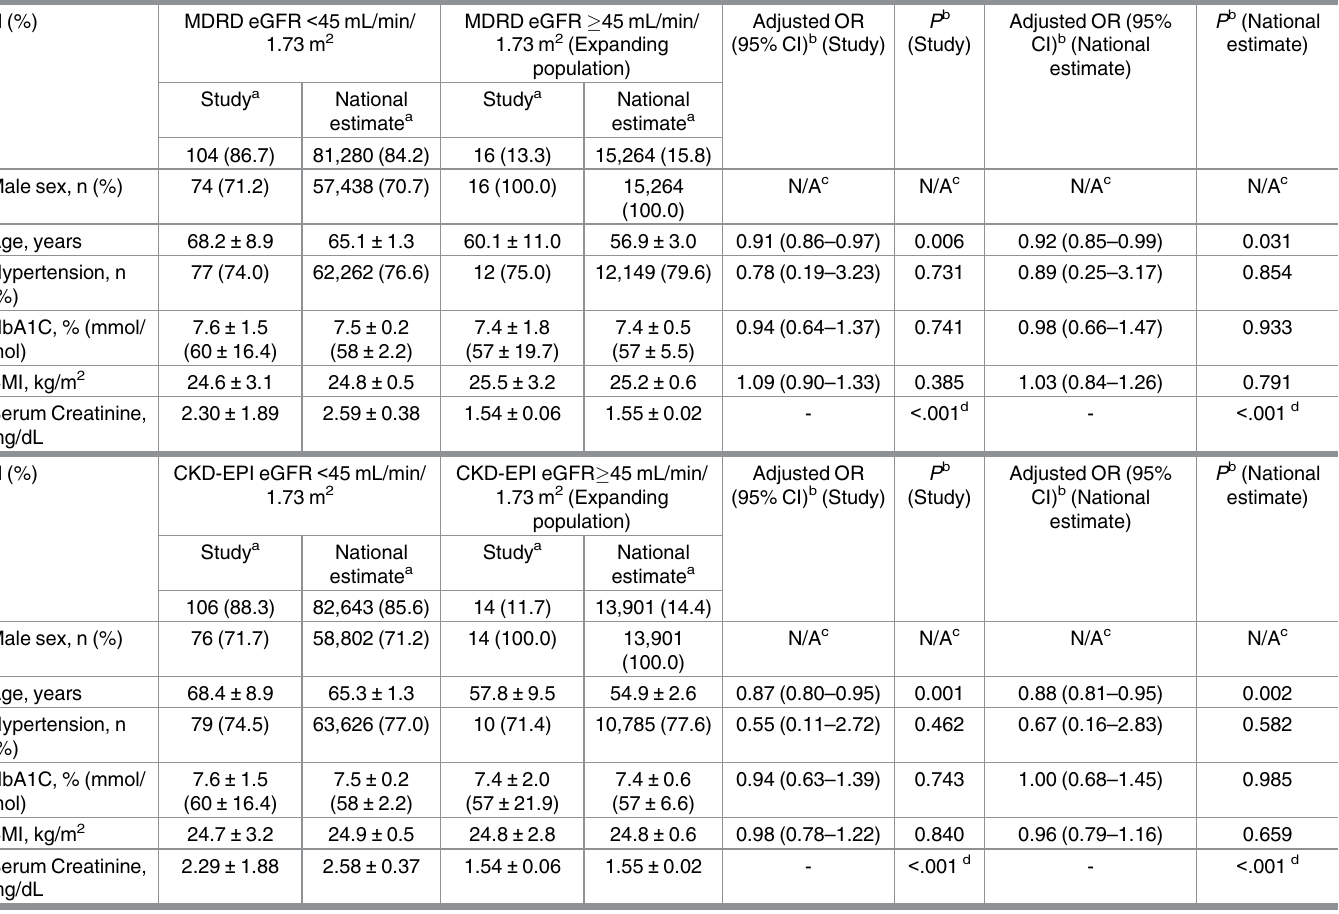
Table 3. Characteristics according to eGFR categories of ineligible population by the sCr level, KNHANES